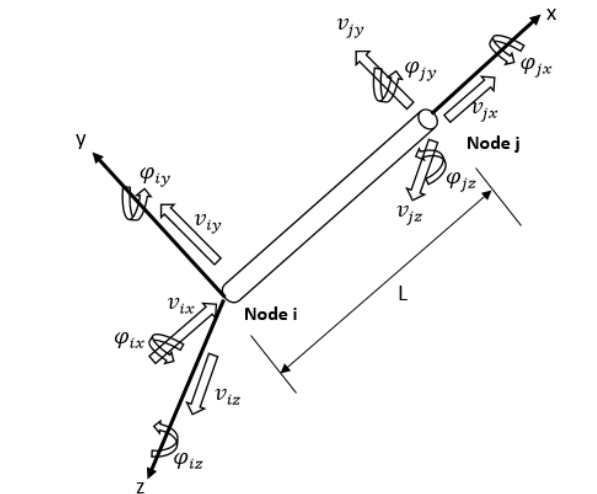
Figure 4. Representative beam element with 6 degrees of freedom at each